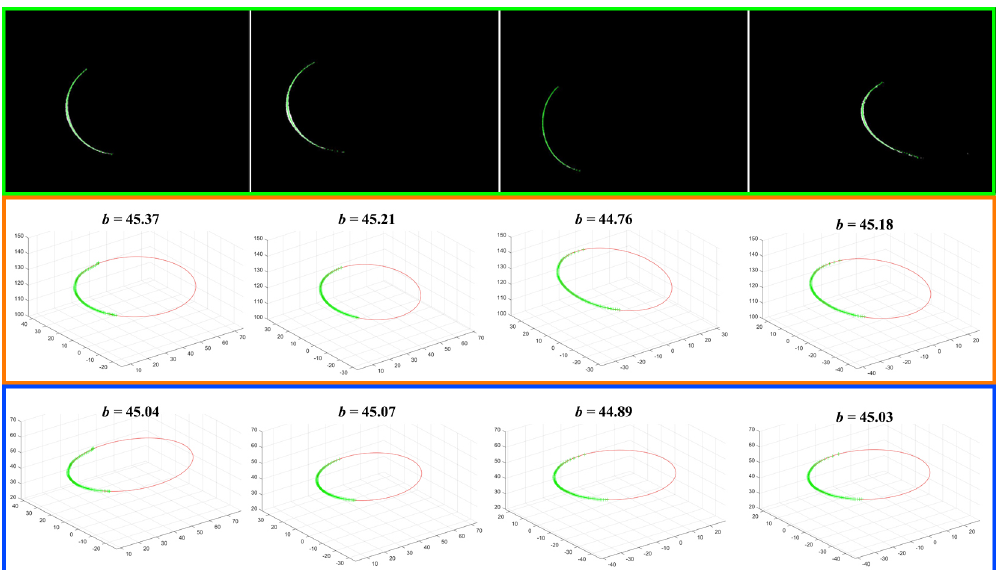
Figure 10. The results of cylinder measuring